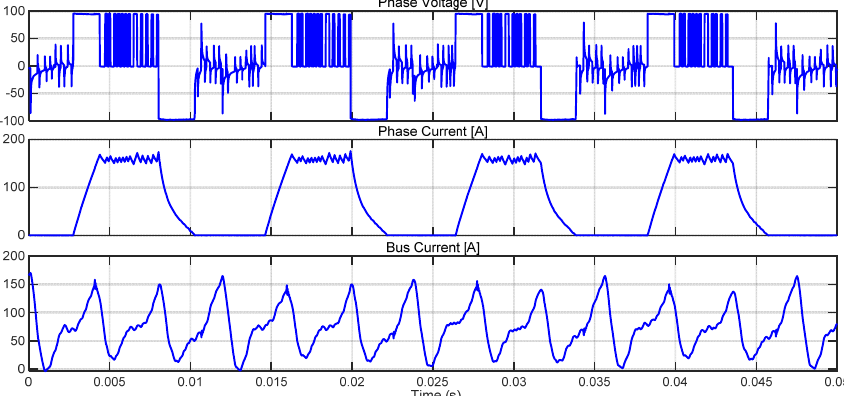
Figure 19. Experimental waveforms of phase current, phase voltage and bus current for 500 rpm, 60 Nm with hysteresis control θ ON = − 4°, θ OFF = 12°.